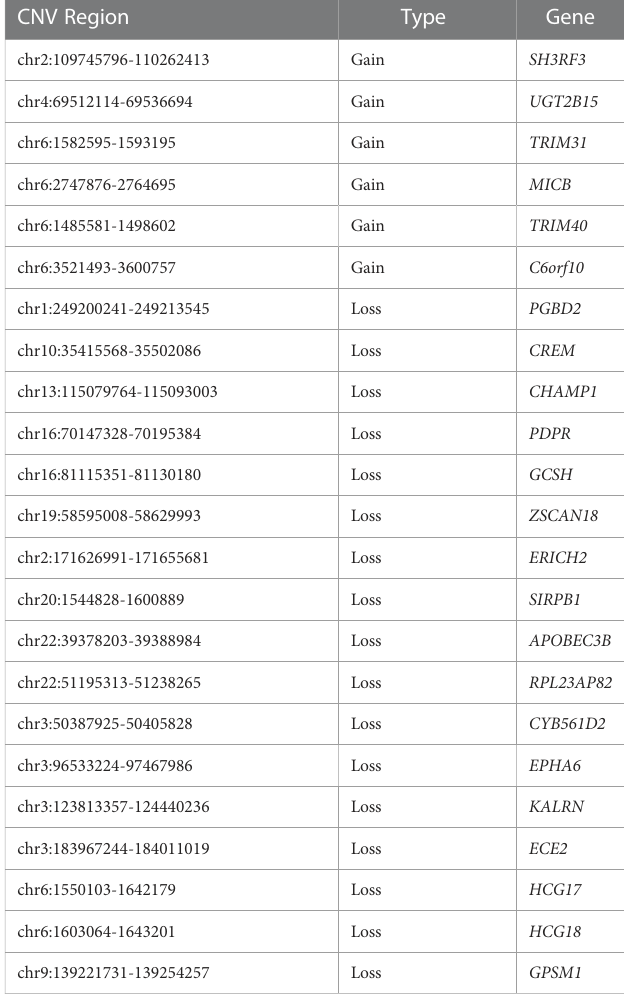
TABLE 1 Summary of common genes affected by